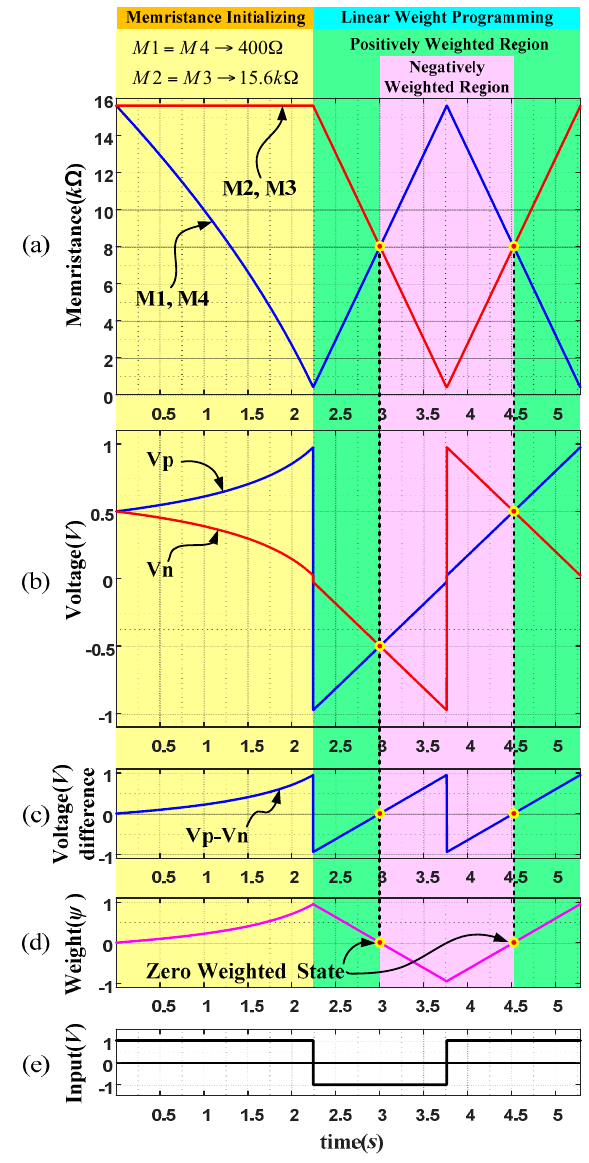
Figure 11. Linear programming of the memristor bridge synapse that is composed of two different types of anti- serial linear memristors. ( a ) variation of memristances; ( b ) changes of voltages Vp and Vn ; ( c ) difference of middle voltage ( Vp − Vn ); ( d ) weight changes of the memristor bridge synapses; and, ( e ) wide pulse for programming.